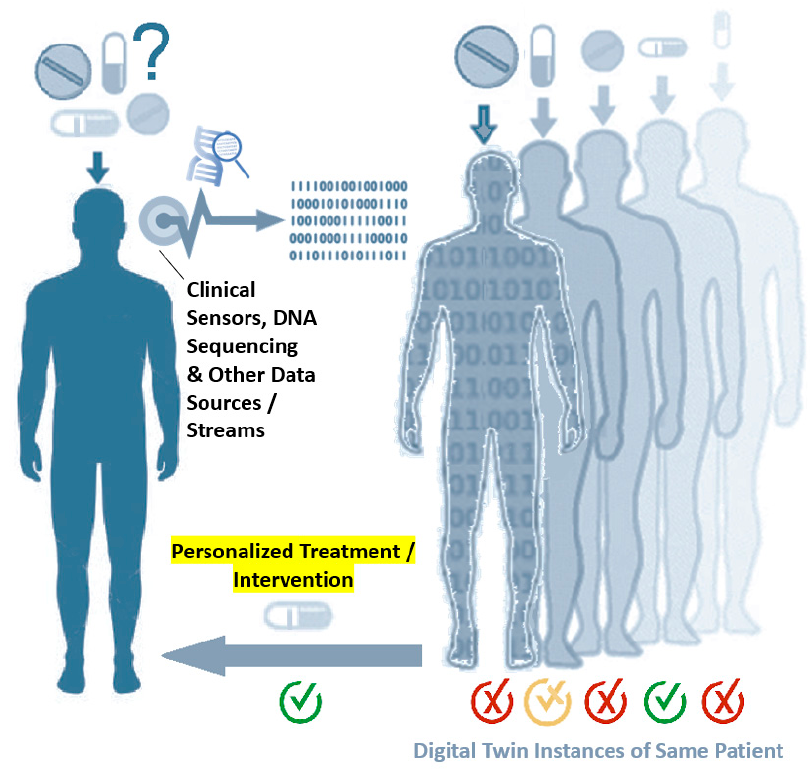
Figure 3. Digital twin instances of the same person or patient can be used for in silico testing and comparison of different treatment or preventive intervention possibilities to find out which option will work best for that particular individual. Note the data flow from clinical sensors, DNA (deoxyribonucleic acid) sequencing, and other data sources and streams to the digital domain.